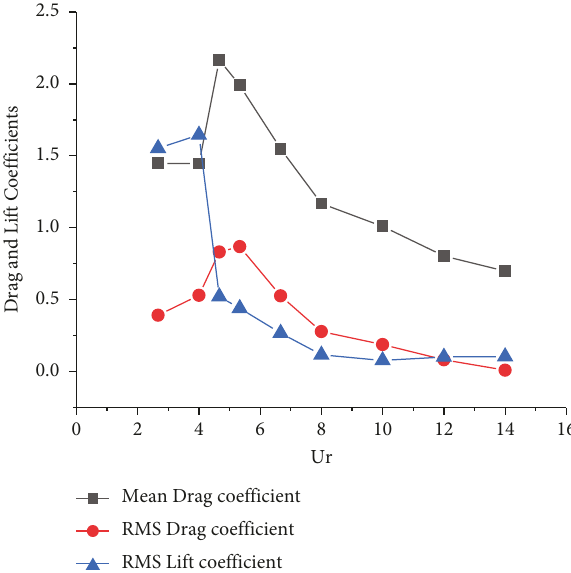
Figure 9: Characteristics of lift and drag coefficients versus reduced velocity.